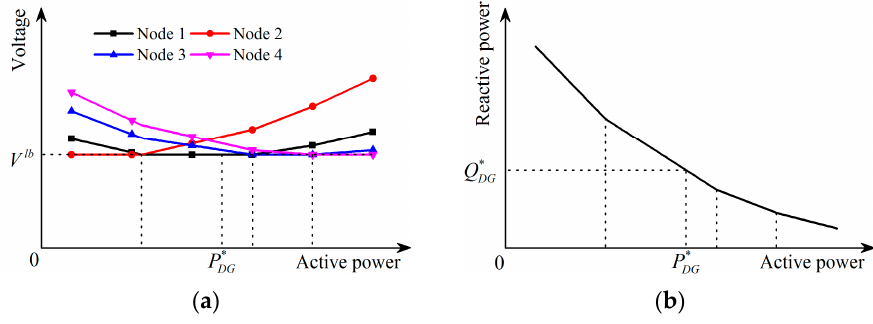
Figure 2. Voltage magnitude and reactive power variation according to active power: Ideal reactive power controller for CVR, ( a ) Voltage magnitude; ( b ) Reactive power.